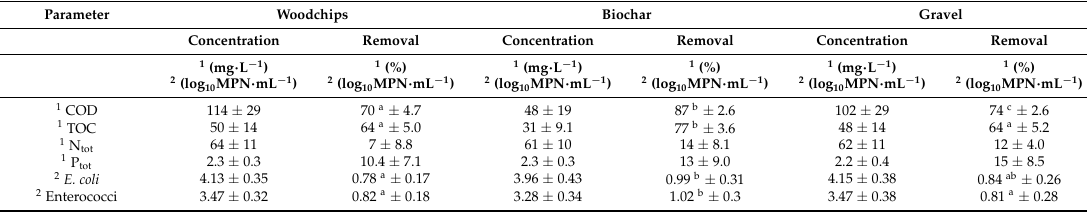
Table 3. Mean effluent concentration and removal rates of different filter materials over experimental time. Different letters ( a,b,c ) indicate a significant difference of the mean (ANOVA, p < 0.05) between materials after post hoc analysis. Standard deviations are presented as variation